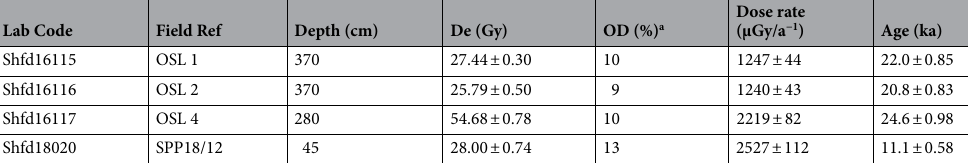
Table 2. Summary of OSL results from Laminia (Shfd16115-17) and Saxomununya (Shfd18020), presented with one sigma confidence intervals which incorporate systematic uncertainties with the dosimetry data, uncertainties with the palaeomoisture content and errors associated with the De determination. a Overdispersation of De data.